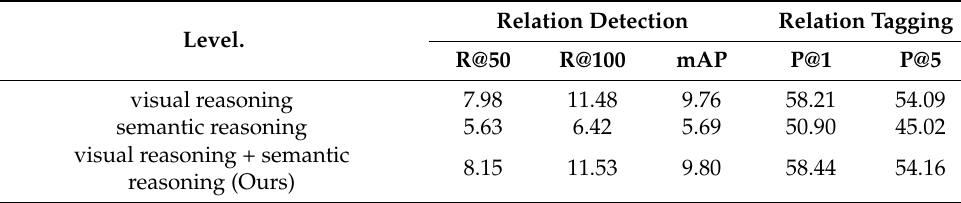
Table 5. Results of context reasoning using different levels on VidOR validation set. Relation Detection Level.